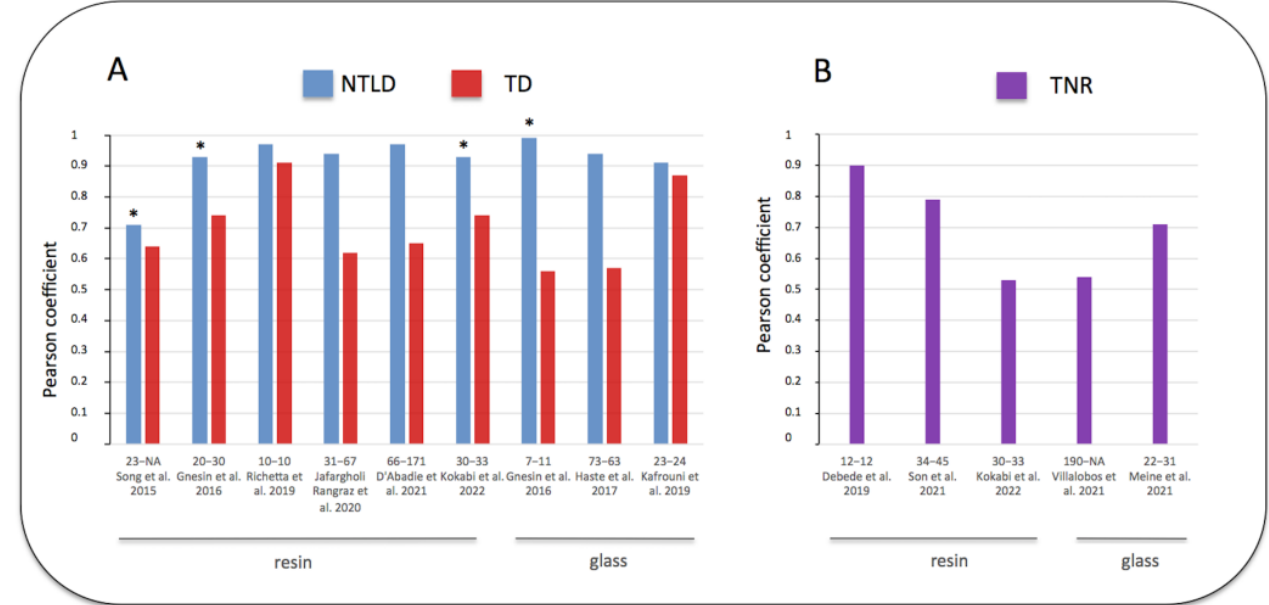
Figure 2. Pearson coefficient correlations between doses estimated by MAA SPECT/CT and post 90 Y SIRT imaging [25,30-40]. ( A ) blue: non-tumoral liver absorbed dose (NTLD), referring to the non-tumoral whole liver or to the non-tumoral liver targeted by SIRT (*). ( A ) red: tumor absorbed dose (TD). ( B ) purple: tumor to normal liver ratio uptake (TNR). Abscissa legend: patients and tumor numbers of each study referenced in bracket. Tables in Supplementary Materials provide additional information. Note the better correlation obtained for the NTLD versus TD or TNR [25,30-40].